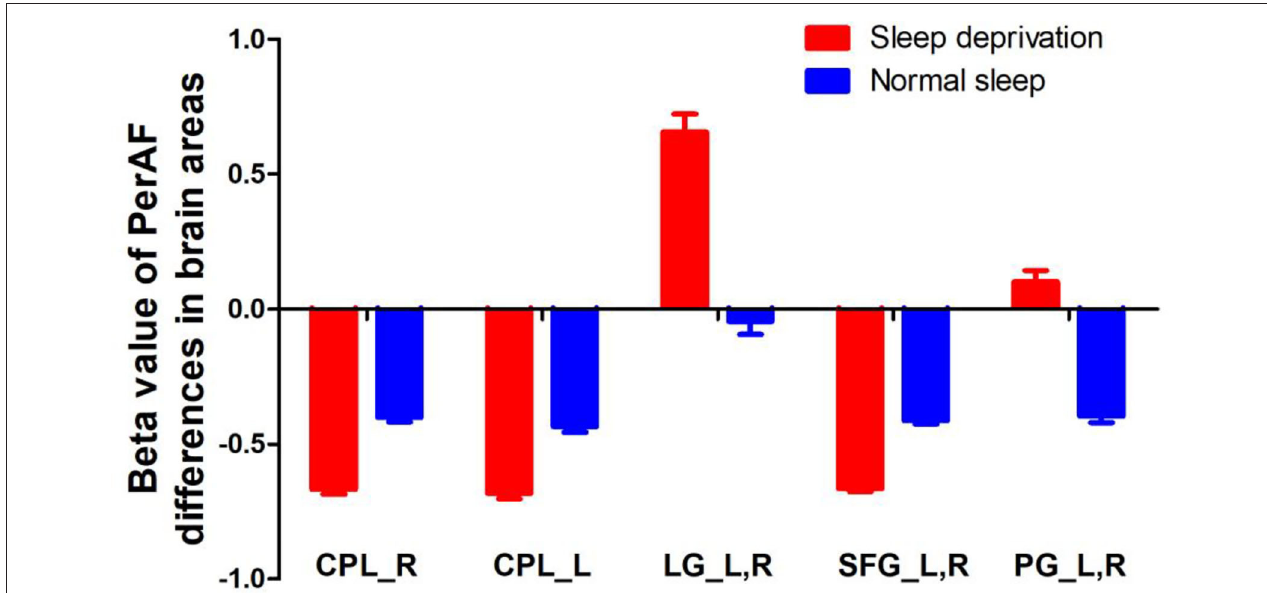
FIGURE 3 | PerAF value of between-group differences in regional brain areas. PerAF, percent amplitude of fluctuation; R, right; L, left; CPL, cerebellum posterior lobe; LG, lingual gyrus; SFG, superior frontal gyrus; PG, postcentral gyrus.